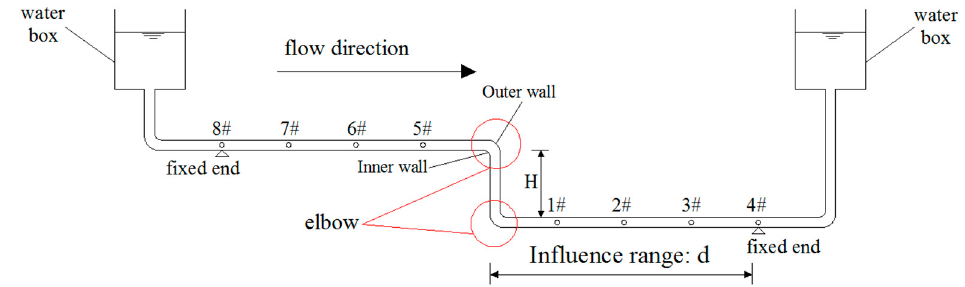
Figure 6. Layout of the step-type LLSS.